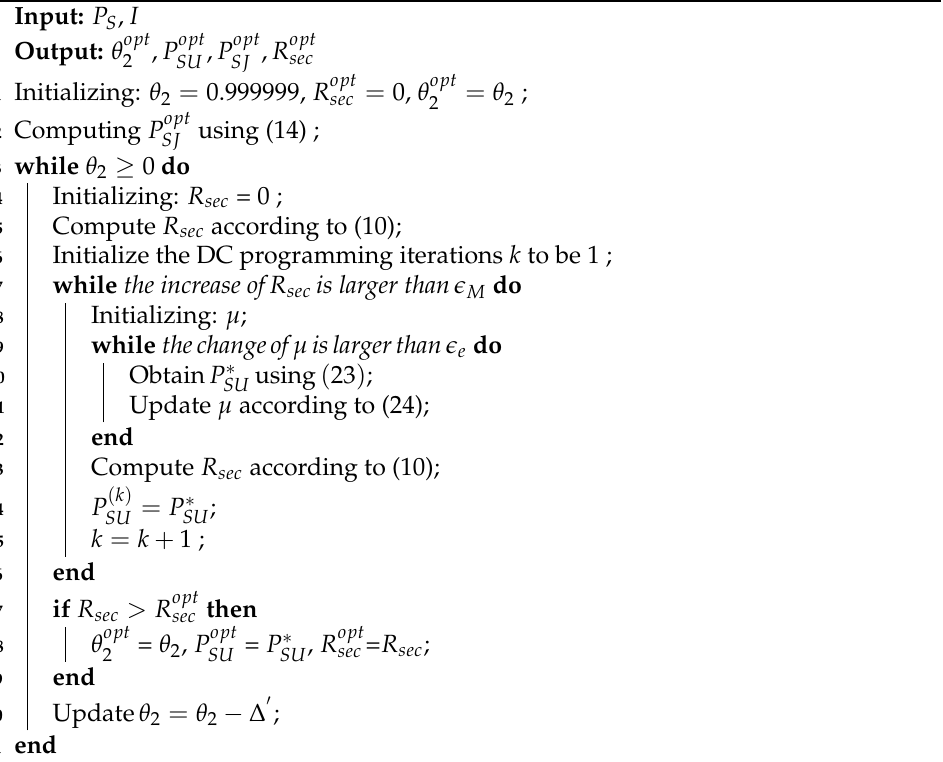
Algorithm 1: Optimal time allocation and transmit power allocation for